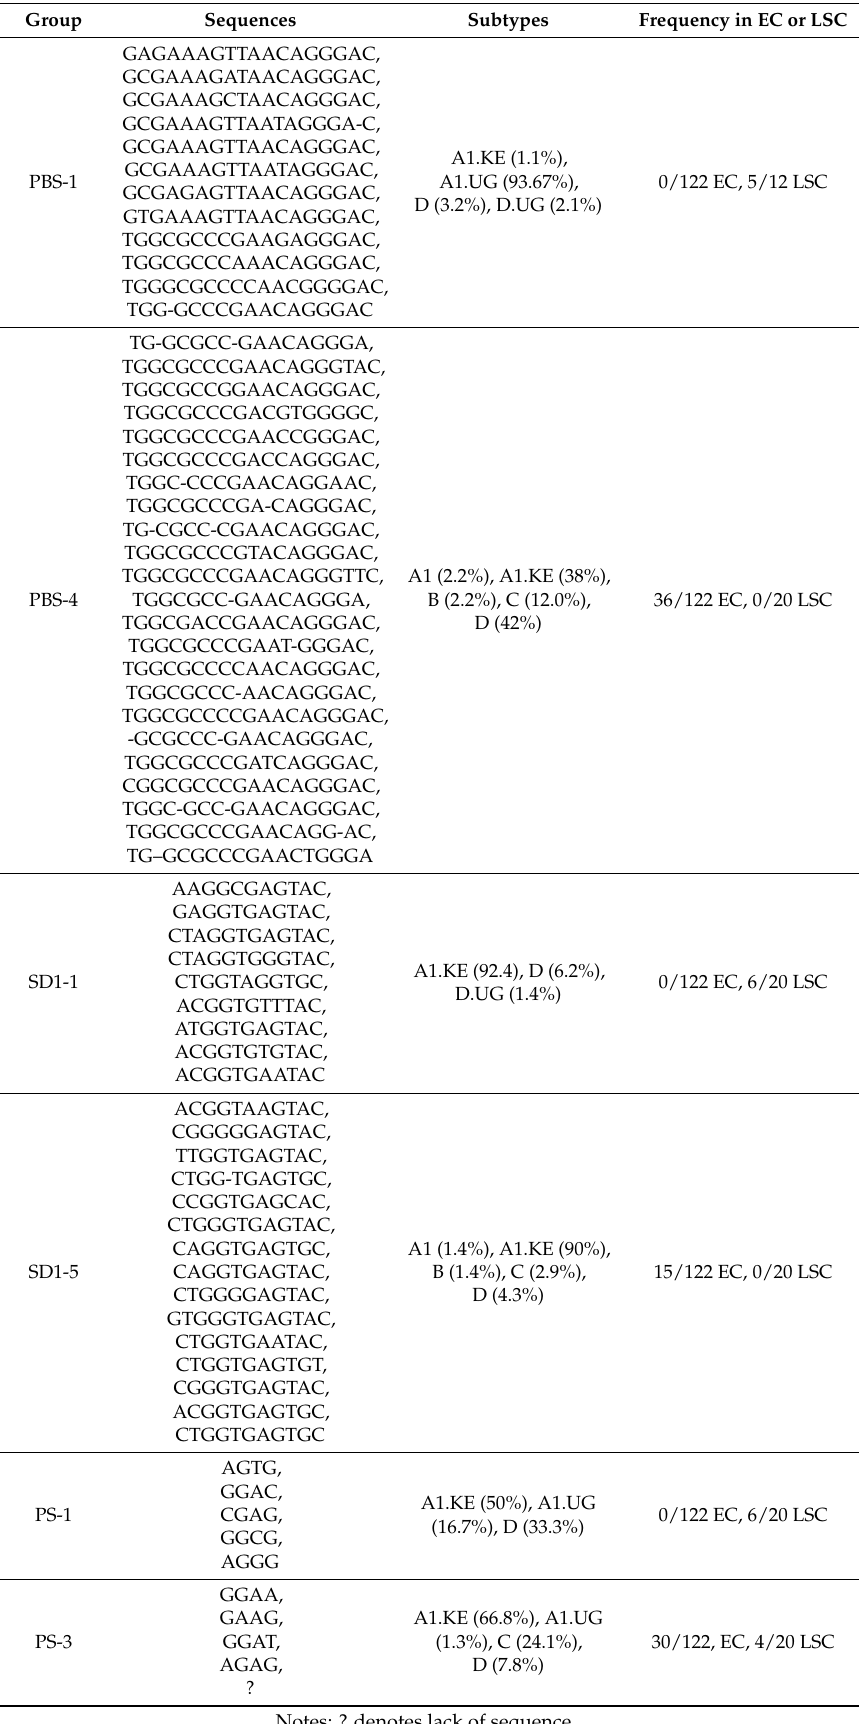
Table 2. PBS, SD1, and PS sequences listed in Figures